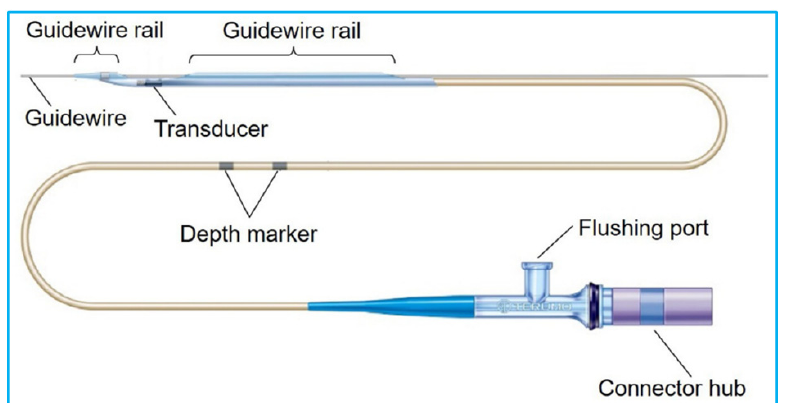
Figure 2. An illustration of an IVUS catheter fed over a guidewire. Reprinted from [45] with per- mission.